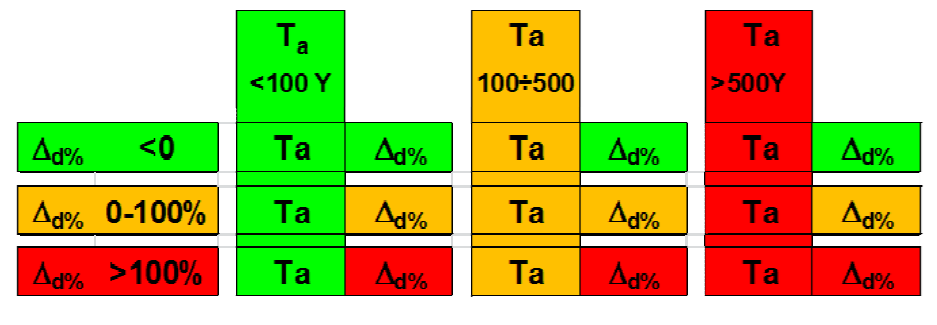
Figure 1. Possible combinations of risk features related to rain, expressed by T and to population density variations, expressed by Δ red: